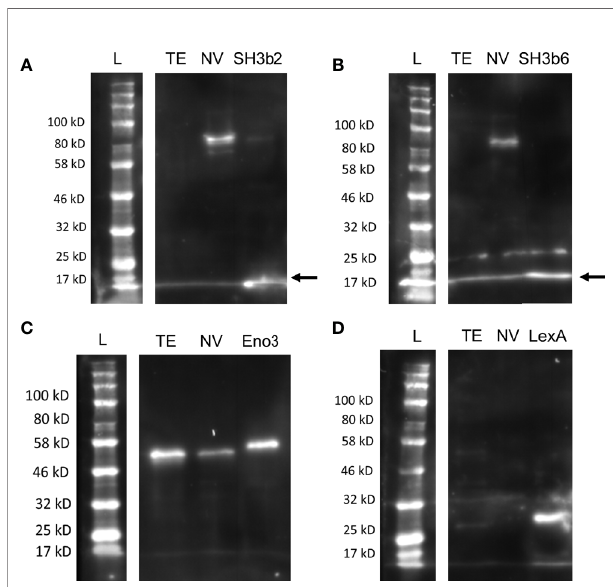
FIGURE 4 | Distribution of Sdp_SH3b2, Sdp_SH3b6, Eno3 and LexA in cell fractions. Representative Western blots are shown using anti-Sdp_SH3b2 (A) , anti-Sdp_SH3b6 (B) , anti-Enolase (C) , and anti-LexA (D) against L. johnsonii N6.2 total protein extract (TE) and NV. The corresponding puri fi ed protein was used as a positive control in each gel. The predicted size of the puri fi ed Sdp_SH3b2 and Sdp_SH3b6 domains is ~15 kDa. When present in NV, the predicted size for the detection of Sdp_SH3b2 and Sdp_SH3b6 is ~100 kDa (Sdp). The predicted MW of LexA and Eno3 is 27 kDa and 47 kDa, respectively. Arrows are indicating the band of the pure